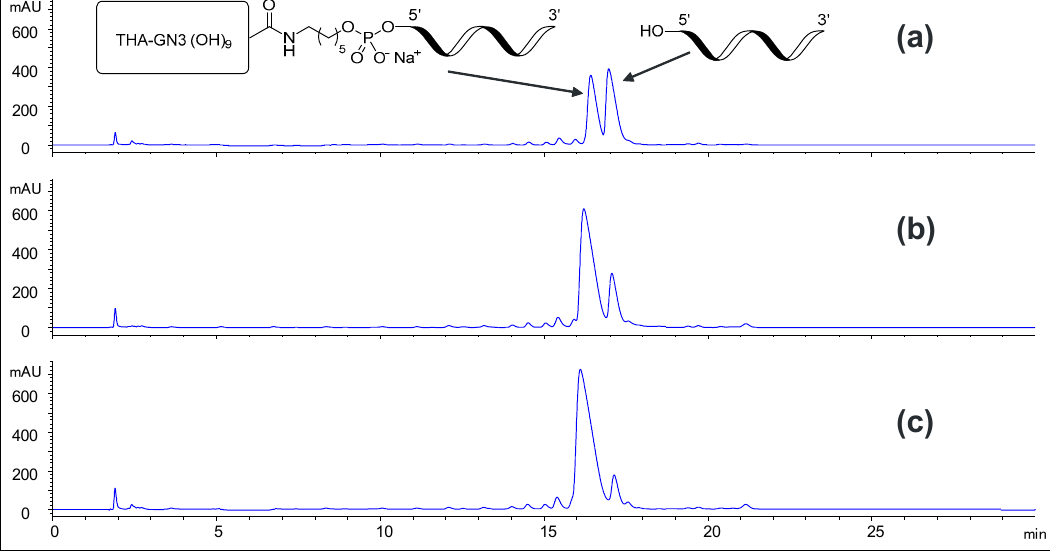
Figure 3. IP-HPLC-UV chromatograms for coupling equivalent study: ( a ) 1.75 equivalents of THA-GalNAc phosphoramidite, ( b ) 3.50 equivalents, and ( c ) 5.25 equivalents.